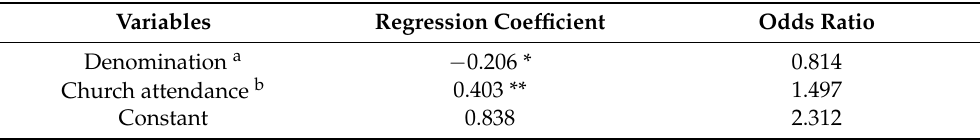
Table 1. Additive effect of denomination and church attendance on negative attitudes about suicide. Logistic regression